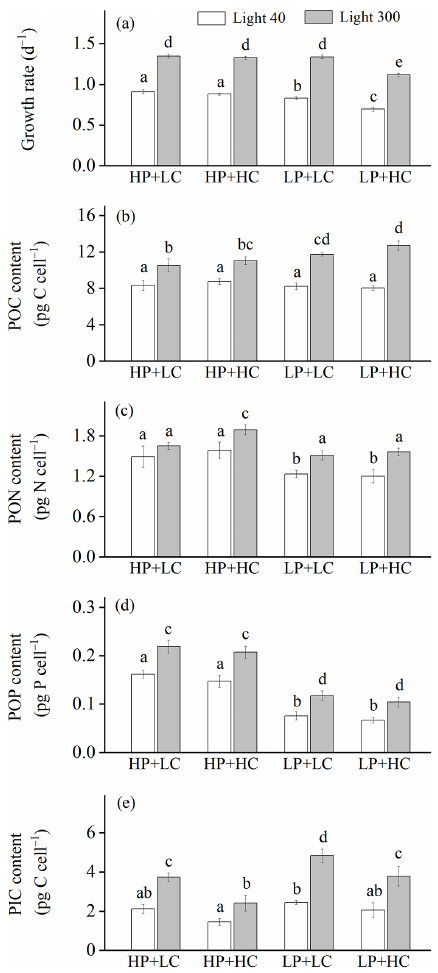
Figure 1. Growth rate (a) , cellular contents of particulate or- ganic carbon (POC, b ), nitrogen (PON, c ), phosphorus (POP, d ), and particulate inorganic carbon (PIC, e ) of Emiliania huxleyi RCC1266 in the treatments of high phosphorus availability and low CO 2 level (HP + LC), high phosphorus availability and high CO 2 level (HP + HC), low phosphorus availability and low CO 2 level (LP + LC), and low phosphorus availability and high CO 2 level (LP + HC) under low light (empty, 40µmolphotonsm − 2 s − 1 ) and high light (filled, 300µmolphotonsm − 2 s − 1 ) intensities. Different letters represent significant differences in each parameter between treatments ( p < 0 . 05). The data represent the means and standard deviation of four independent cultures.